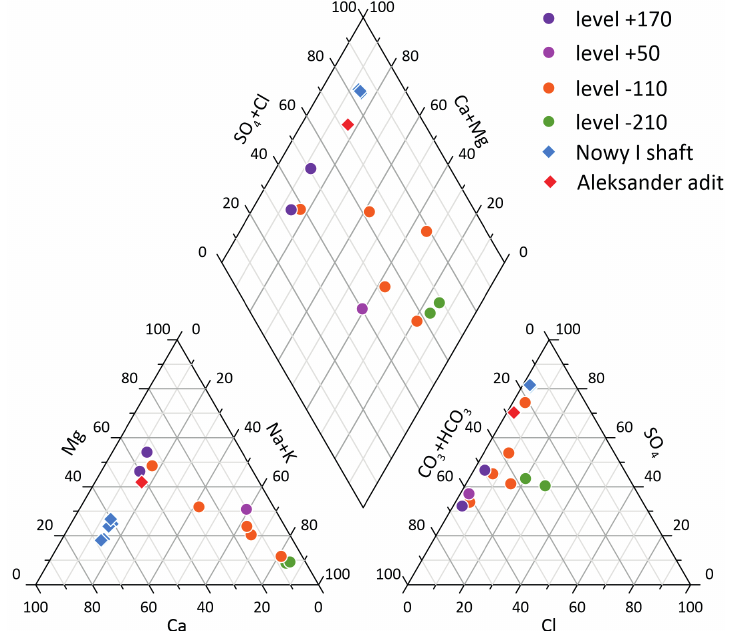
Figure 6. Hydrogeochemical types of water inflowing to excavations on particular exploitation levels [53] in comparison with water from the flooded shaft “Nowy